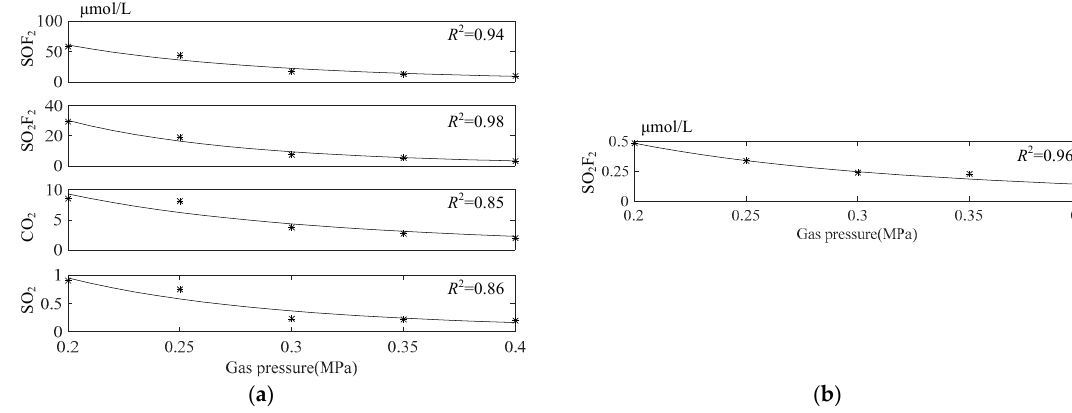
Figure 9. Correlation between 96 h concentration and gas pressure: ( a ) Protrusion and ( b ) particles. Table 1. Fitting formula .